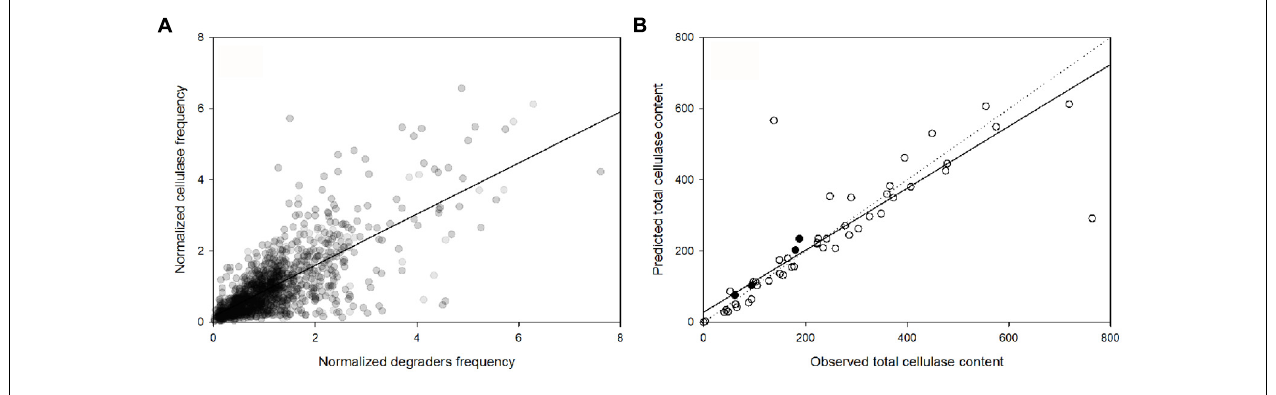
FIGURE 4 | (A) Linear dependence of the normalized abundance of potential cellulose degraders and their potential cellulase content, across the samples (PSpearman < 0.01). (B) Comparison between the observed and the predicted cellulase content based on microbial community